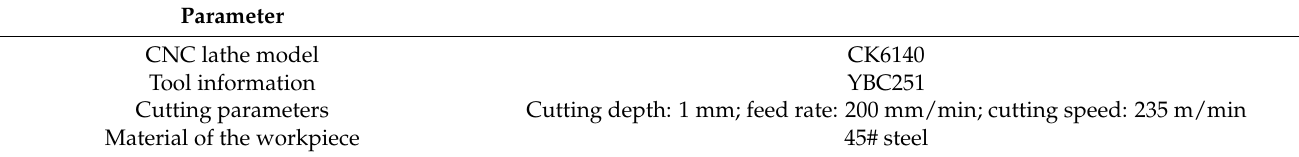
Table 2. Processing parameters.